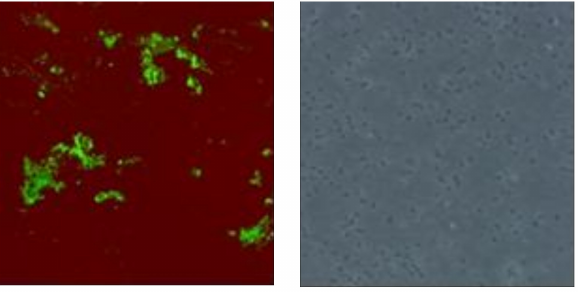
Figure 2. Images of BL21 cells (OD600 = 1) incubated with mannose-coated polymer ( left ) and PBS solution ( right